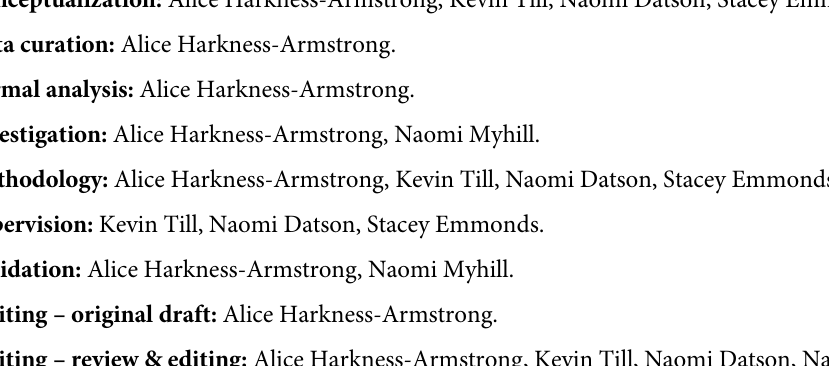
S1 Table. Whole-, half-, segmental- and peak-match characteristics of women’s soccer players, quantified via heart rate monitors. S2 Table. Whole-match high-speed running and sprinting match-play characteristics of women’s soccer players. S3 Table. Whole-match acceleration and deceleration characteristics of women’s soccer players. S4 Table. Half-match physical characteristics of women’s soccer match-play. S5 Table. Segmental physical characteristics of women’s